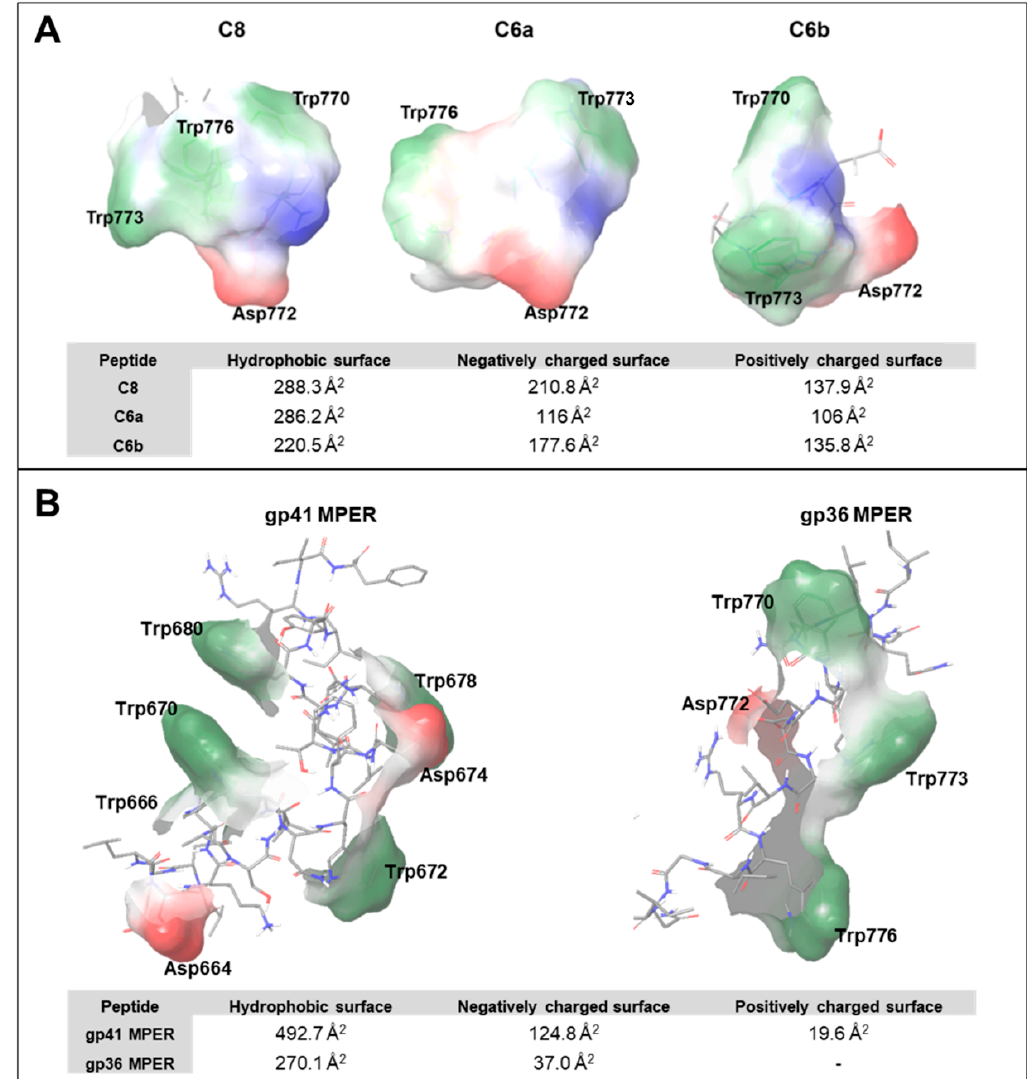
Figure 8. Surface analyses of the Trp and Asp residues contained in ( A ) C8, C6a, and C6b peptides and ( B ) gp41 and gp36 MPER domains. The patches are coloured green for hydrophobic surfaces, red for negatively charged surfaces, and blue for positively charged surfaces .